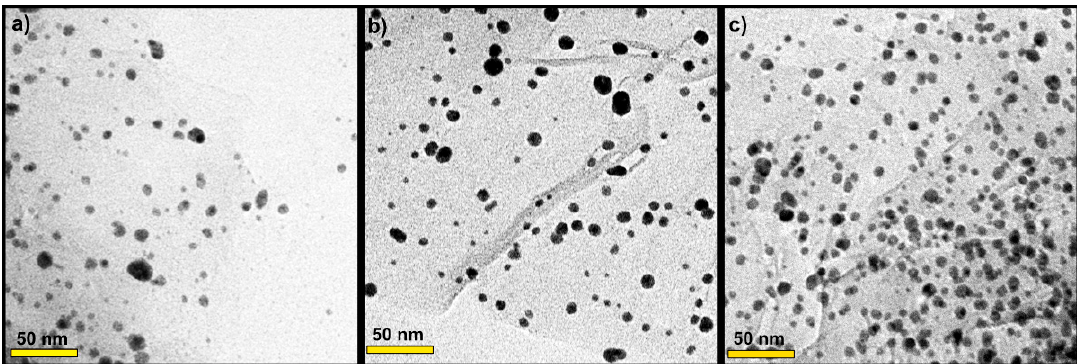
Figure 3. TEM images of the prepared samples: ( a ) 0.1 M AgNP/rGO, ( b ) 0.2 M AgNP/rGO and ( c ) 0.3 M AgNP/rGO.